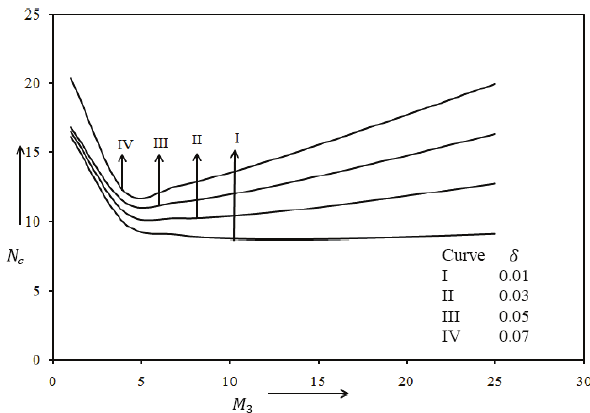
Fig. 4. Variation of critical magnetic Rayleigh number ( N c ), with the departure of linearity in the magnetic equation of state ( M 3 ) for  = 0.01, 0.03, 0.05 and 0.07 for curves I, II, III and IV Figure 4 represents the graph of N